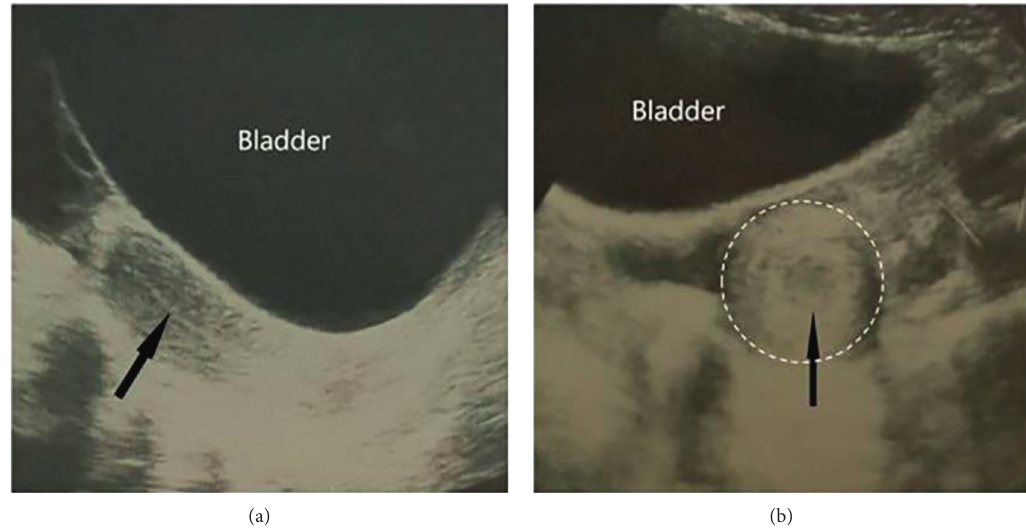
Figure 1: (a) On ultrasound, sagittal view of the pelvis shows the uterus with a normal uterine contour and normal echogenic endometrial line (arrow). (b) Axial view of the pelvis demonstrates a cross section of a mass-like lesion on the left side of the pelvic cavity, which was finally proved to be an accessory and cavitated uterine mass (arrow marks the